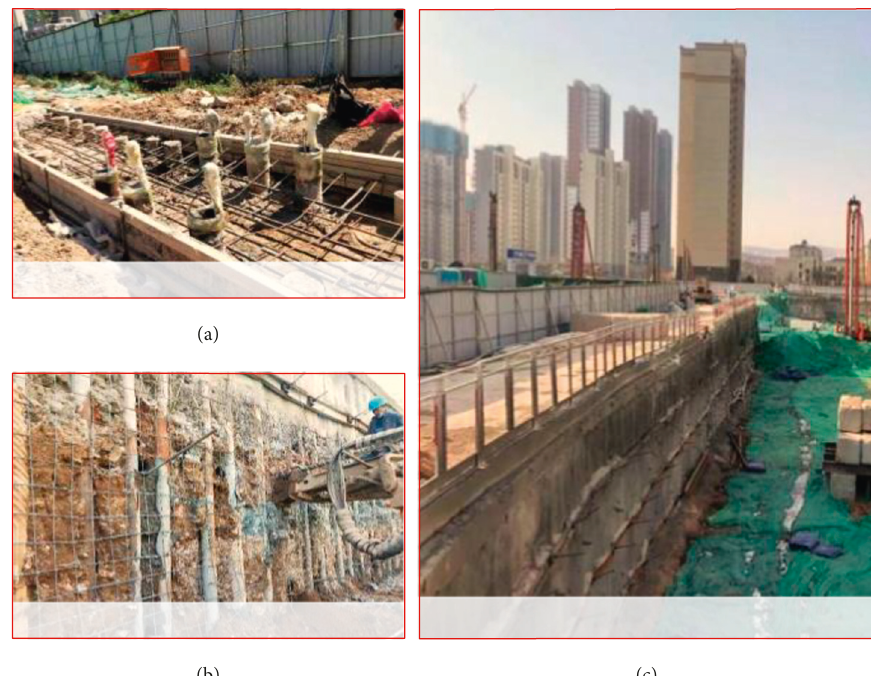
Figure 3: Double row steel pipe pile composite support construction process. (a) Micropiles and capping beam. (b) Anchor construction. (c) Excavation